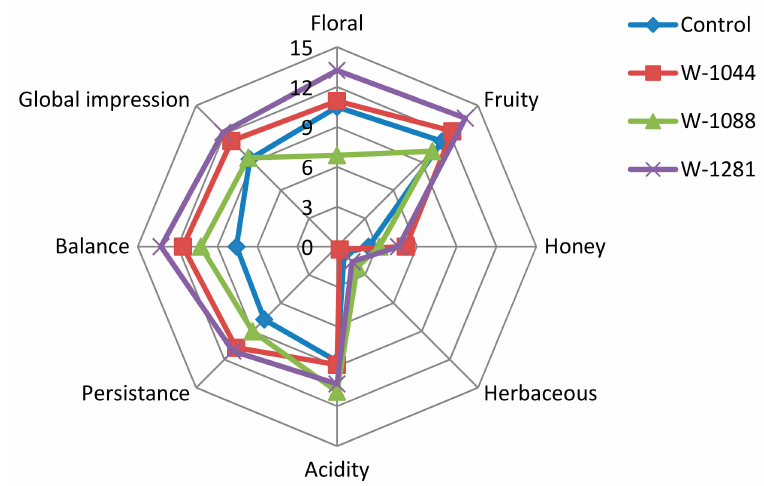
Figure 4. Sensory profile of Narince wines made with autochthonous and commercial S. cerevisiae yeasts. Note: C = wine fermented with control strain; 1044 = wine fermented with autochthonous 1044 yeast; 1088 = wine fermented with autochthonous 1088 yeast; 1281 = wine fermented with autochthonous 1281